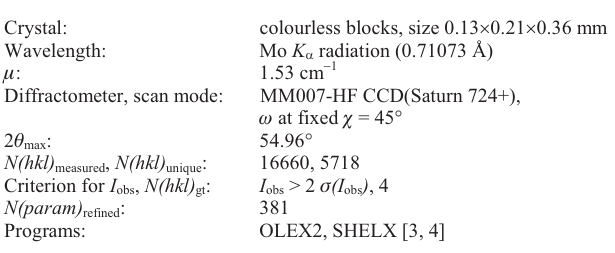
Table 1. Data collection and handling.